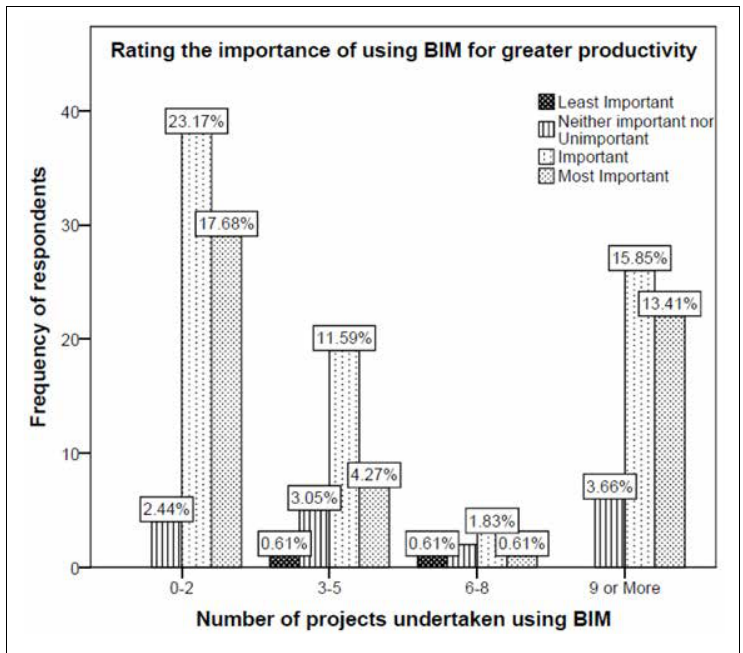
Figure 3: Projects undertaken using BIM versus greater